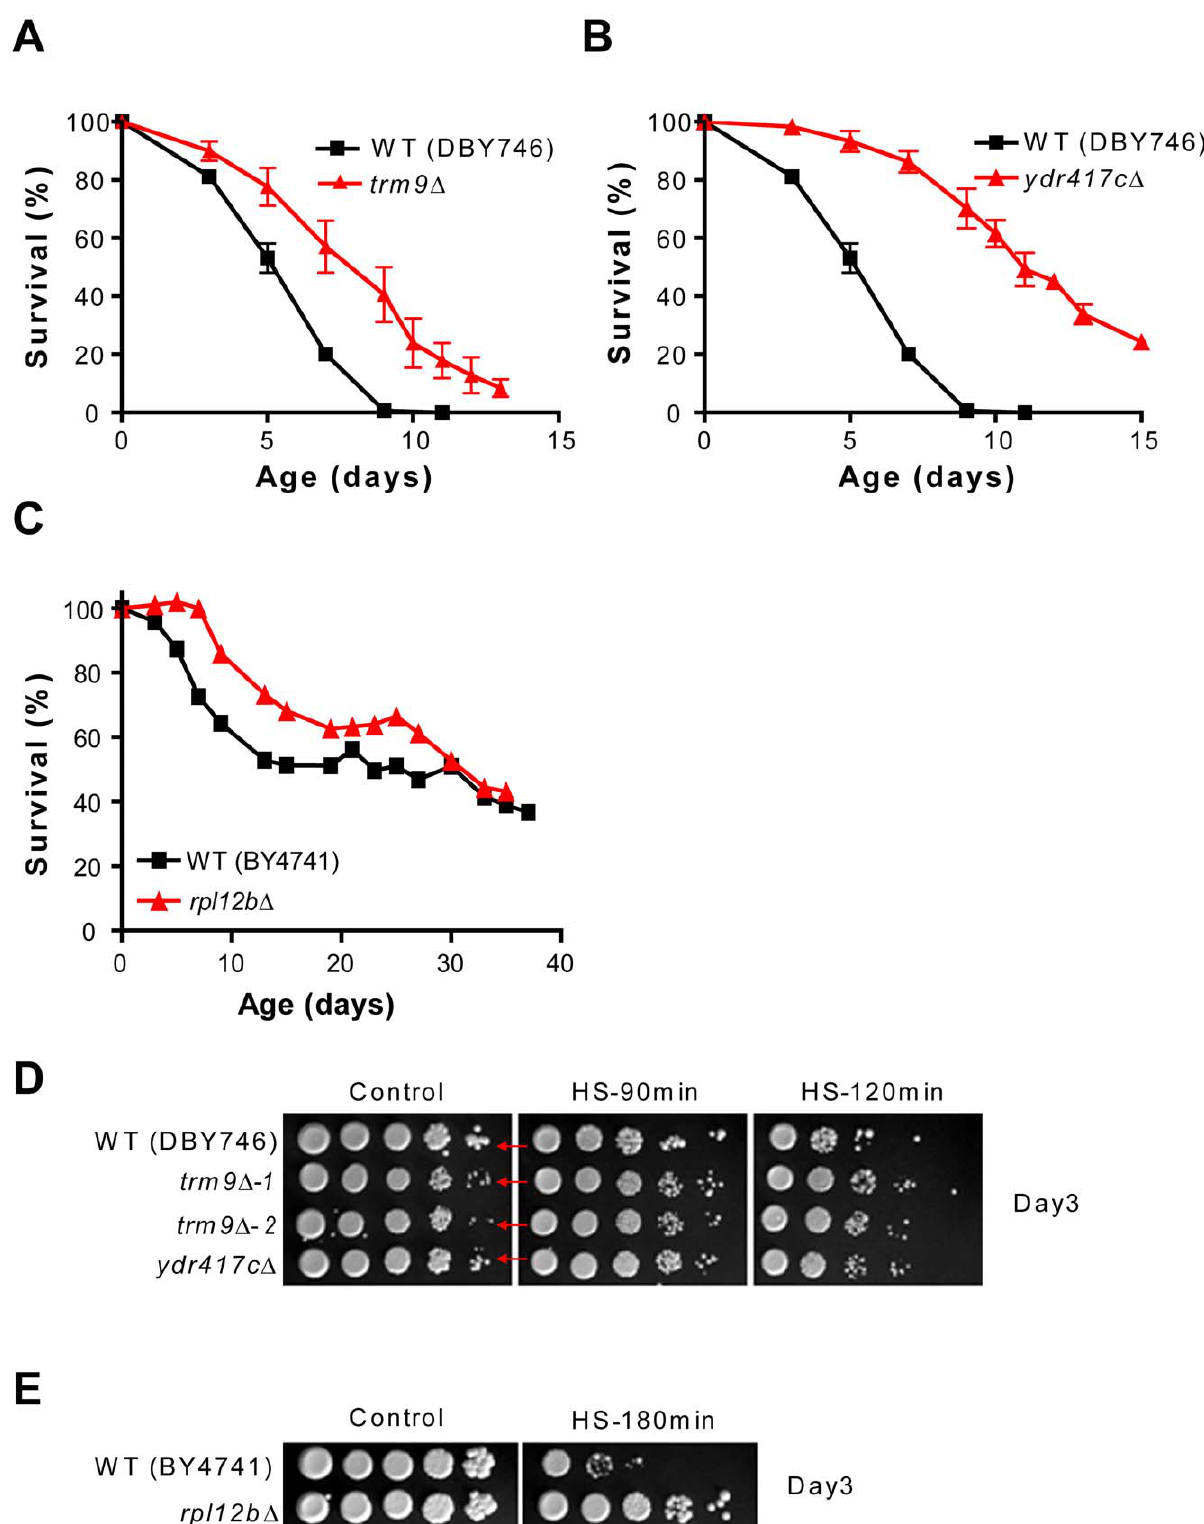
Figure 7. Role of TRM9 and YDR417C in life span regulation and heat resistance. CLS of DBY746 and mutants lacking either (A) Trm9, or (B) Ydr417c. (C) CLS of BY4741 and rpl12b D . (D) Day 3 heat-resistance of two different isolates of the trm9 D mutant generated in the DBY746 background and of a ydr417c D mutant. In the control panel (highest dilution factor) the arrows indicate the colony size of the long-lived trm9 D and ydr417c D mutants (row 2–4) as compared to that of the wild type (row 1). (E) Heat-resistance of BY4741 and of a mutant lacking Rpl12b at day 3. The survival studies in (A,B) were conducted incubating the cultures in SDC medium until the end of the experiment. The data shown represent an average of 2–3 experiments. Yeast cultures in (C) were transferred to water at day 3 (see Materials and Methods). A representative experiment is shown.